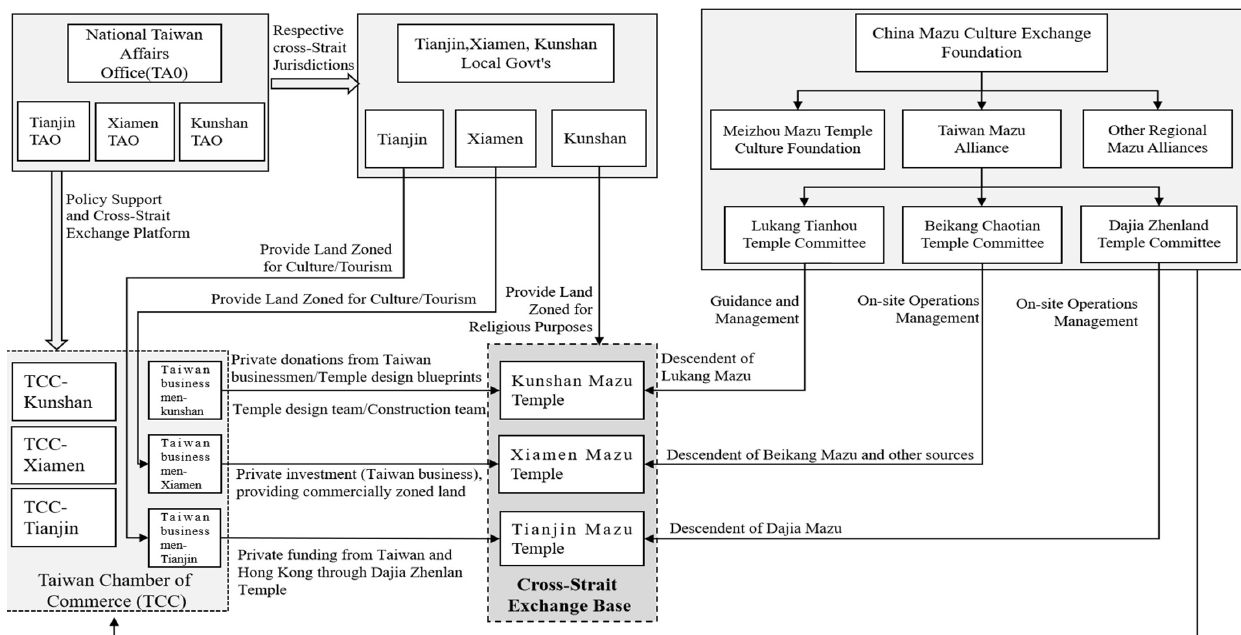
Figure 3. Network of actors of Taiwan Mazu temples in mainland China. Source: Compiled by the author.